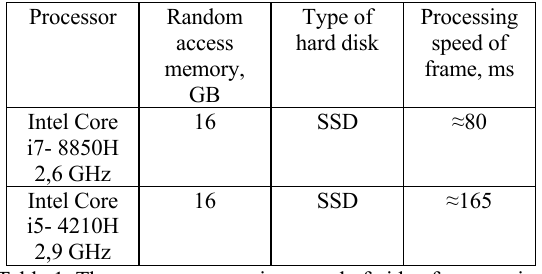
Table 1. The average processing speed of video frames using different computer